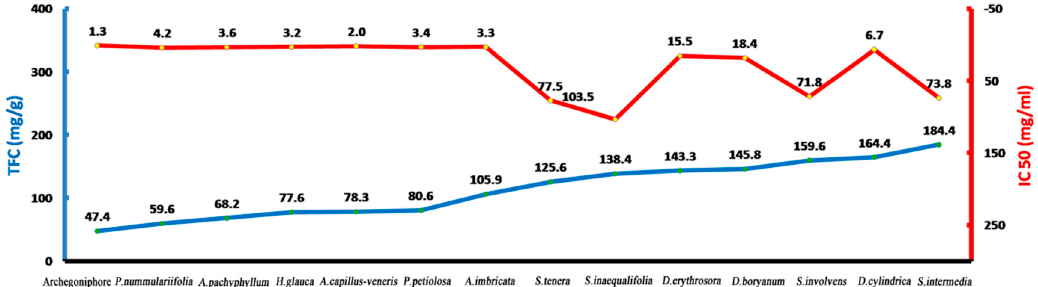
Figure 7. The comparison of total flavonoids content (TFC) and IC 50 .